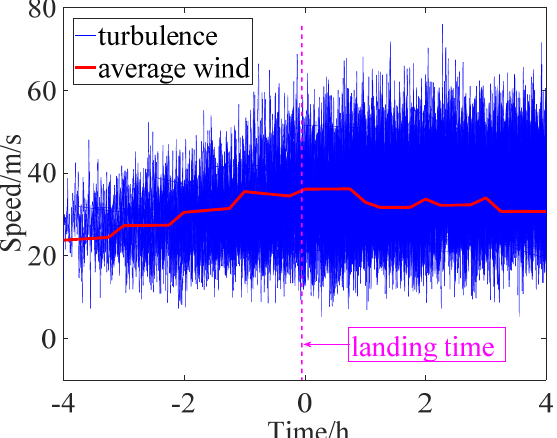
Figure 7. The instantaneous superimposed wind speed.